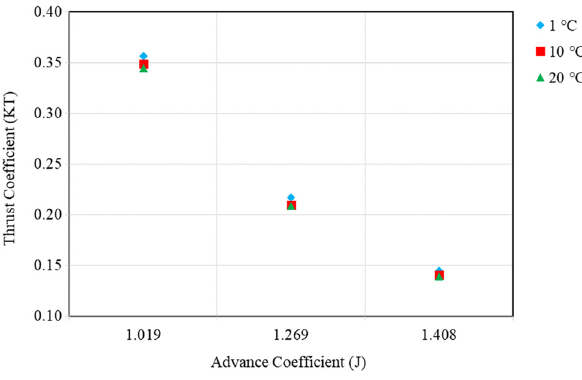
Figure 16: Numerical results of thrust coe ffi cient K T ( ) under variation of advance coe ffi cient.